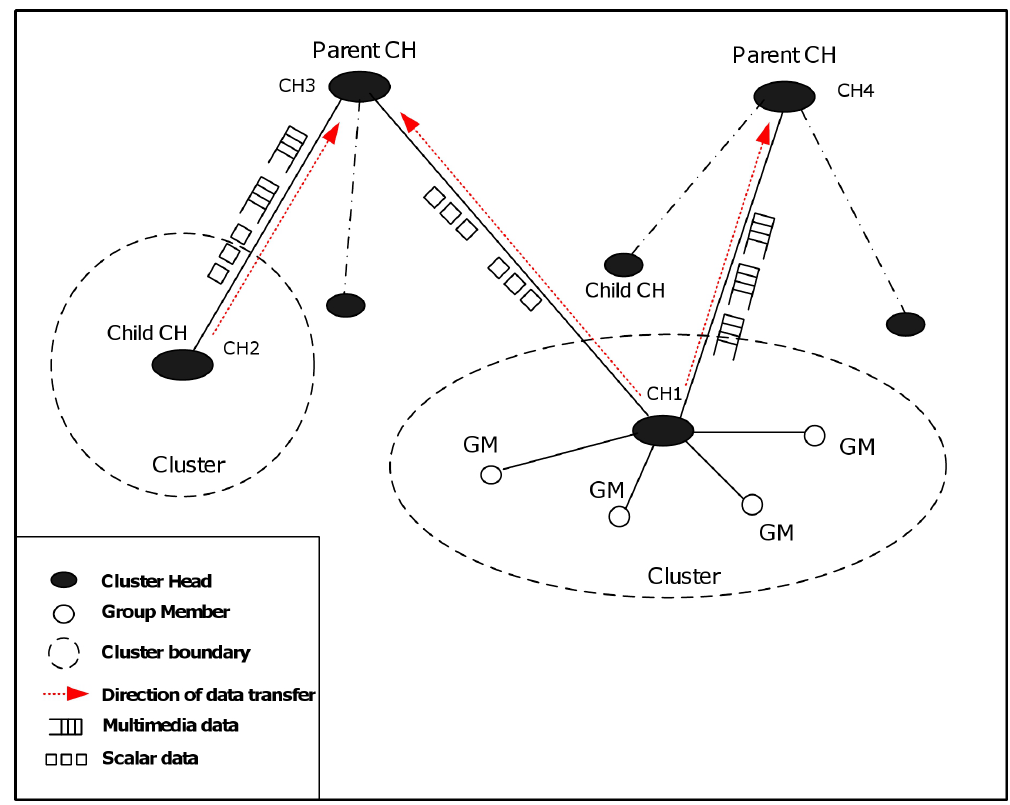
Figure 5. A Simple Example of Two-level